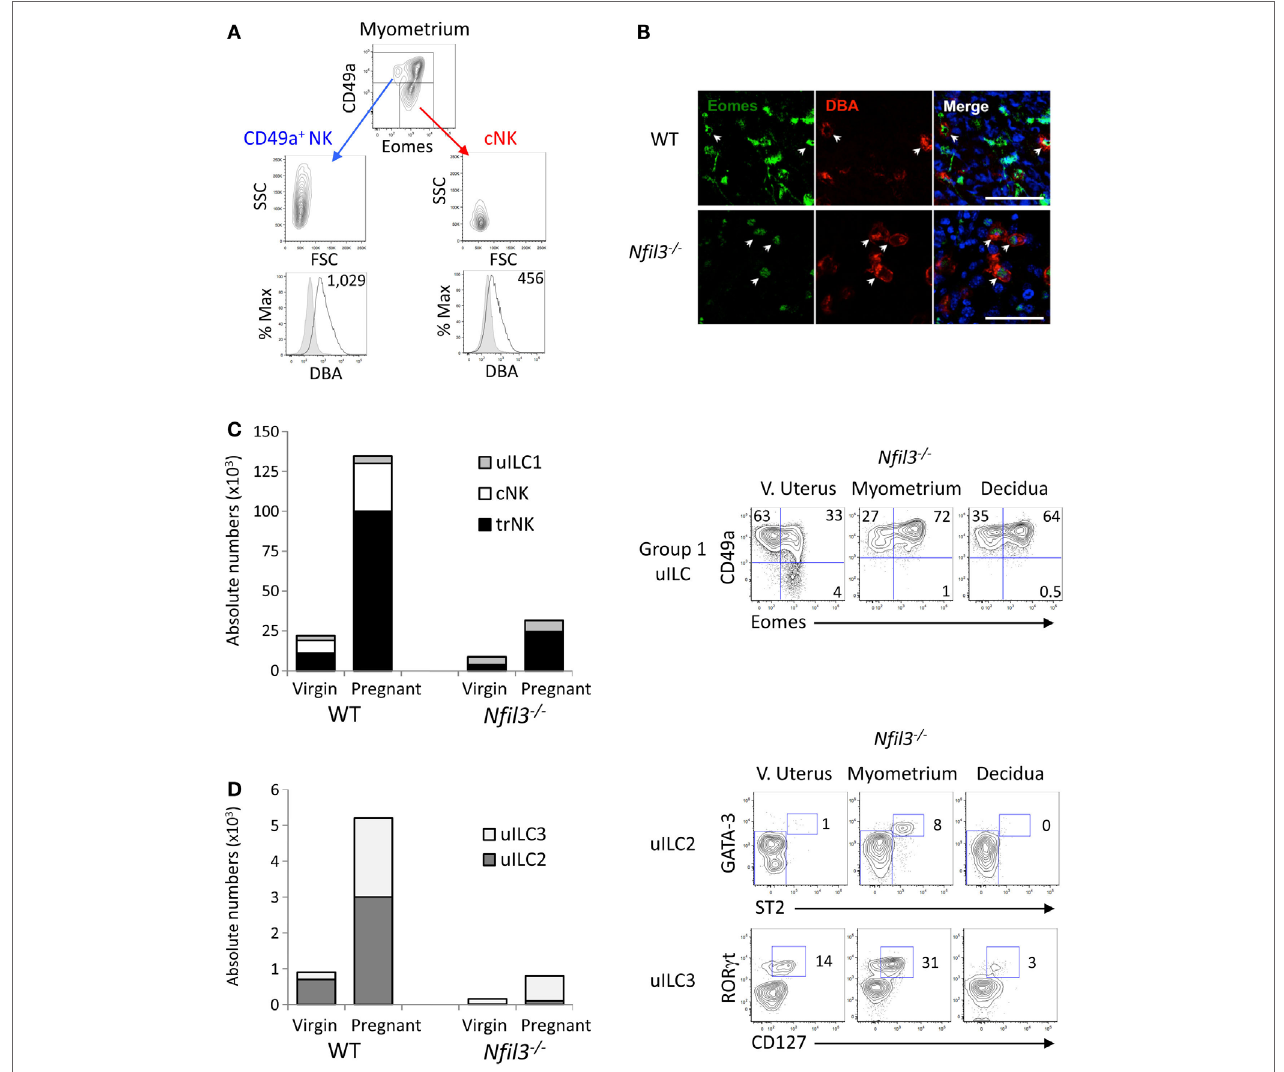
FigUre 2 | Uterine ilcs in virgin and pregnant Nfil3 − / − mice . (a) Representative flow cytometry histograms of intracellular Eomes, granularity (SSC), size (FSC), and reactivity for Dolichos biflorus agglutinin (DBA) lectin (GMFI is indicated) in ex vivo CD49a + NK and CD49a − cNK in the indicated tissues of WT females. The negative control cell population for DBA reactivity is made up of CD3 + and CD19 + cells. (B) Representative immunofluorescence stainings of gd9.5 implantation sites (decidua) from WT and Nfil3 − / − pregnant females mated with WT males. Almost all DBA + uNK (red) express intranuclear Eomes (green), as indicated by arrowheads. Scale bar = 50 μ m. (c) Absolute numbers and composition in group 1 ILCs in the uterus from WT and Nfil3 − / − virgin and pregnant females (left graph). Representative flow cytometry plots of the changes in group 1 ILC composition from virgin to pregnant Nfil3 − / − mice (right panel). Gated on CD45 + CD3 − CD19 − NK1.1 + NKp46 + cells, uILC1 are defined as CD49a + Eomes − , uterine trNK cells as CD49a + Eomes + , and cNK cells as CD49a − Eomes + . Data representative of two to five independent experiments. (D) Absolute numbers and composition in uILC2s and uILC3s in the uterus from WT and Nfil3 − / − virgin and pregnant females (left graph). Representative flow cytometry plots of the changes in uILC2 and uILC3 composition from virgin to pregnant Nfil3 − / − mice (right panel). GATA-3 hi ST2 + uILC2s are gated on CD45 + CD3 − CD19 − CD11b − NK1.1 − NKp46 − CD90.2 + cells. ROR γ t + CD127 + uILC3s are gated on CD45 + CD3 − CD19 − CD11b − NK1.1 − CD90.2 + cells. Data representative of two to three independent